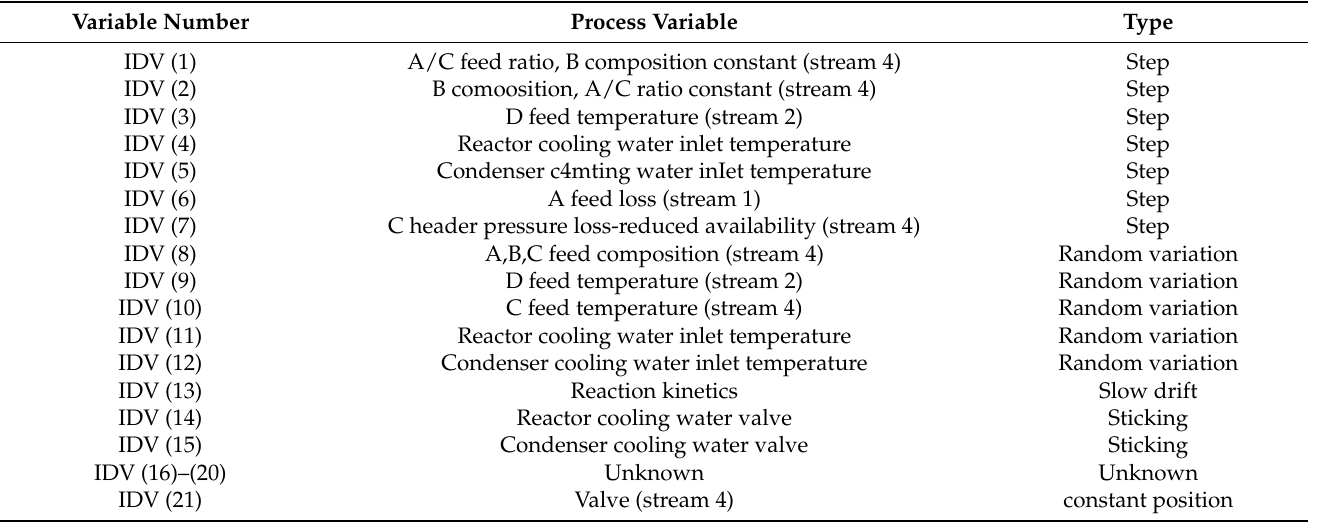
Table 1. The faults description of TE